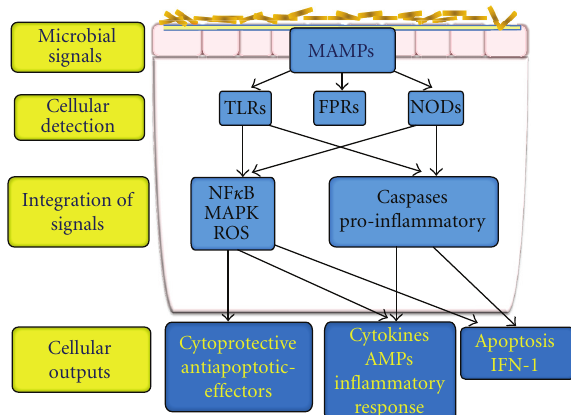
Figure 1: Commensal microbiota, or pathogens, at the mucosal surface create signals, called microbial-associated molecular patterns (MAMPs), to stimulate pattern recognition receptors (PRRs) including toll-like receptors (TLRs), formylated peptide receptors (FPRs), or nucleotide-binding oligomerization domain-like receptors (NODs). Subsequent signaling consists of an intricate and inter-relational pathway, which determines the signaling output based on the initial perception of the triggering organism. Output can be a protective response to commensal microbiota, an inflammatory response to pathogenic organisms, or triggers for